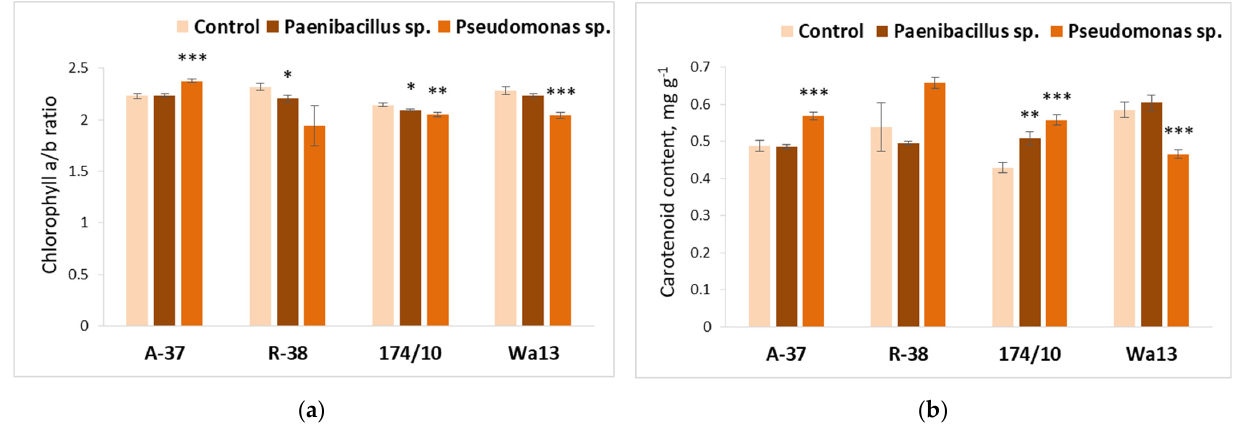
Figure 5. Average chlorophyll a/b ratio ( a ) and carotenoid content ( b ) in the leaves of different Populus genotypes (A-37 and R-38, P. tremula ; 174/10 and Wa13, P. tremula × P. tremuloides ), inoculated with Paenibacillus sp. and Pseudomonas sp. bacteria. Statistically significant differences from the bacterium-free control variant are indicated (for each genotype separately): * p < 0.05; ** p < 0.01; *** p < 0.001.